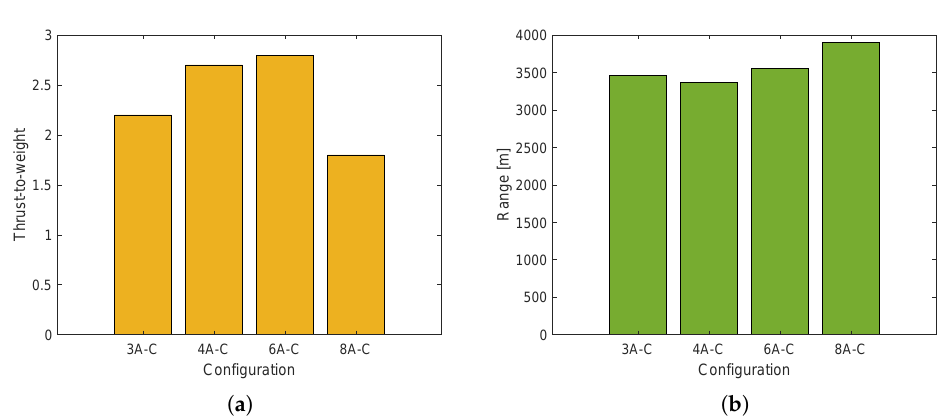
Figure 10. Thrust-to-weight ratio ( a ) and estimated range ( b ) vs. the four different setups.